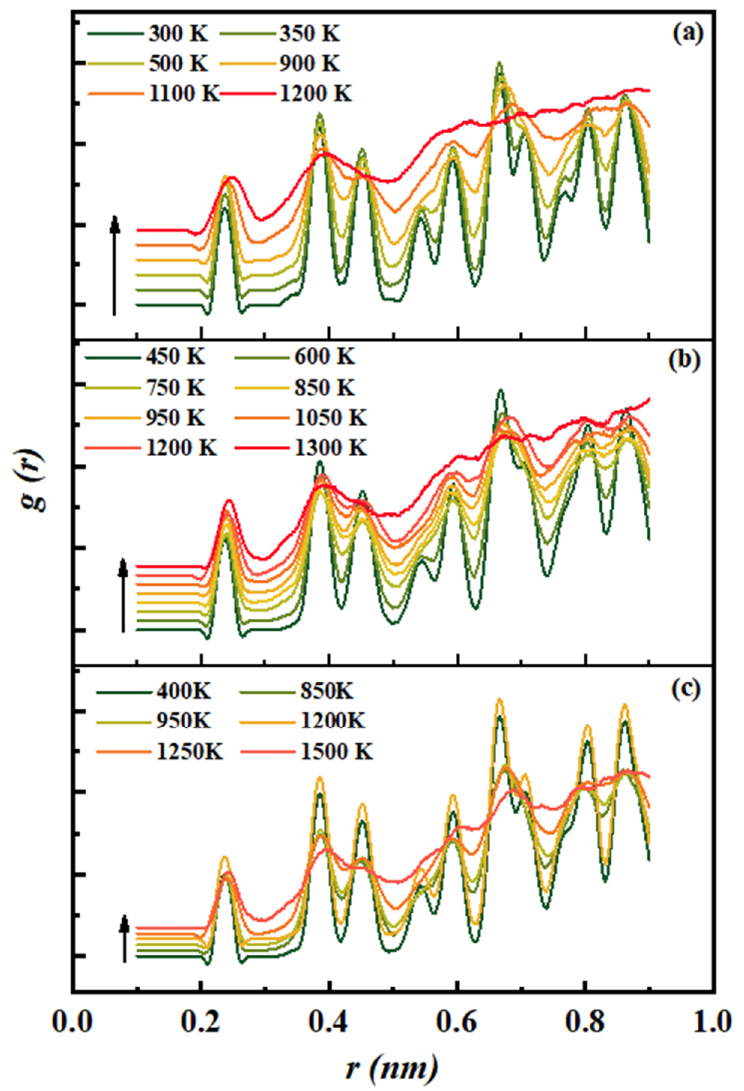
Figure 5. The g ( r ) of the nanowires after structural relaxation at different temperatures: ( a ) SiNW1, ( b ) SiNW2, ( c ) SiNW3.